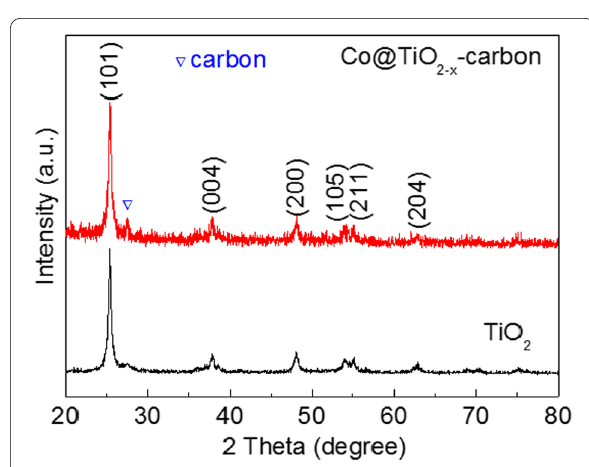
Fig. 2 XRD pattern of the synthesized